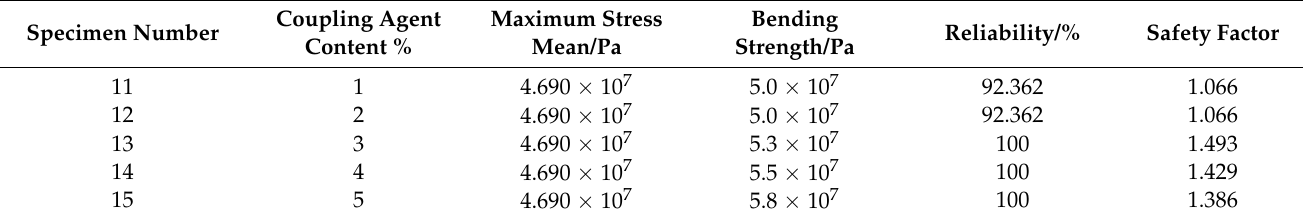
Table 5. Simulation results of the coupling agent content on the reliability of